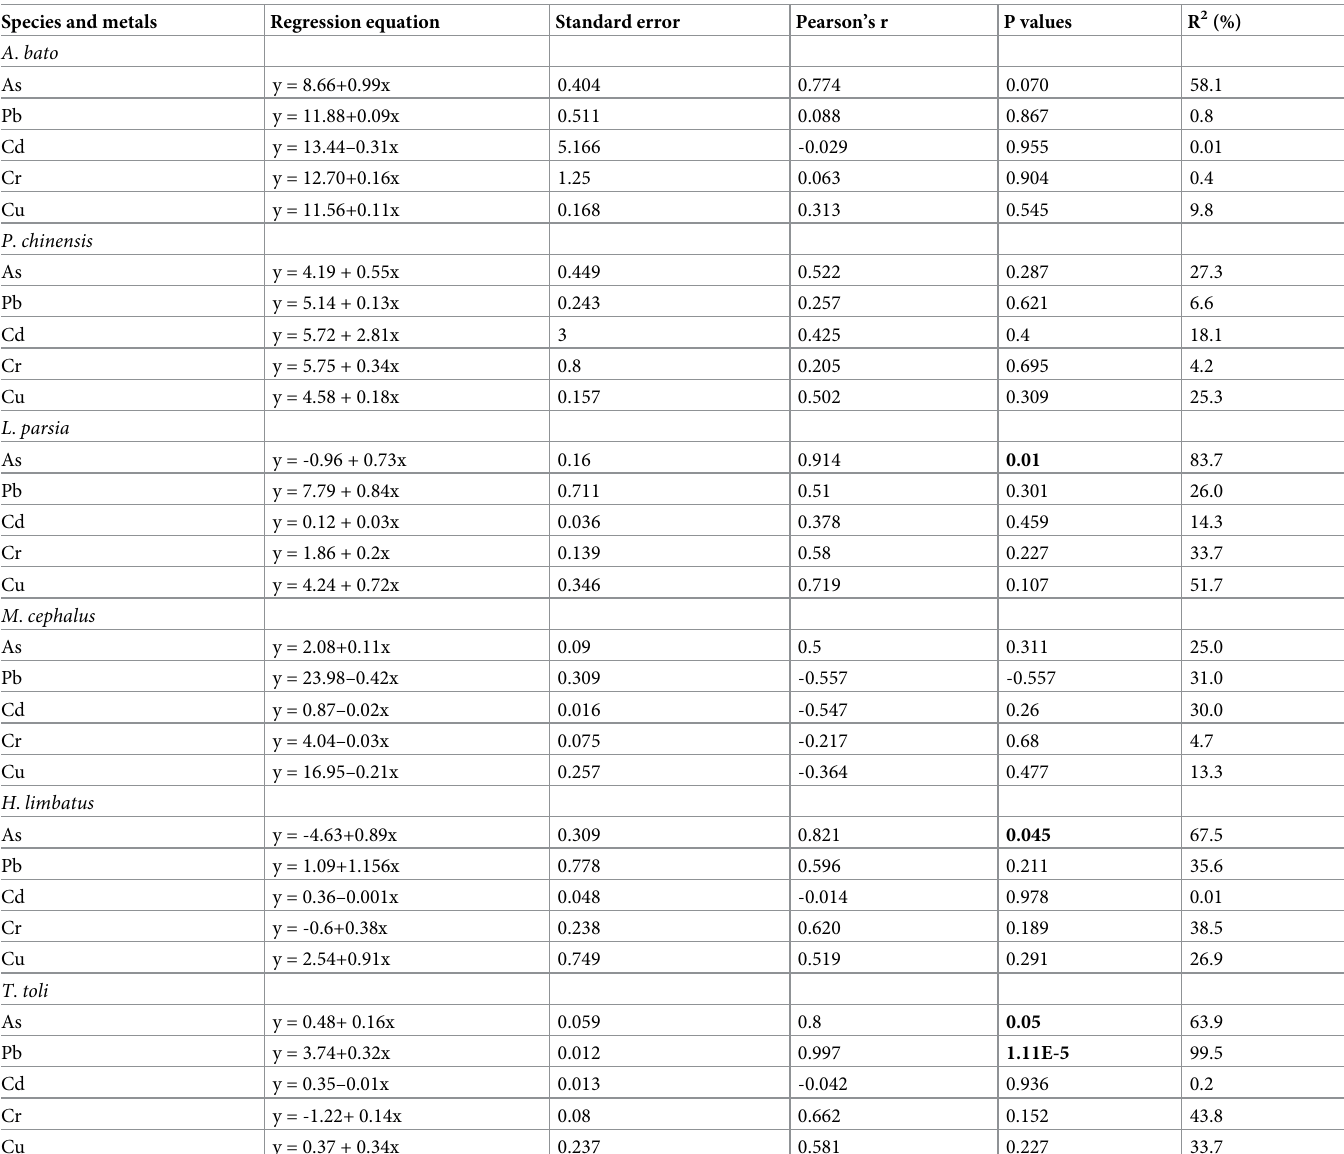
Table 2. A regression analysis between metal distributions in the selected